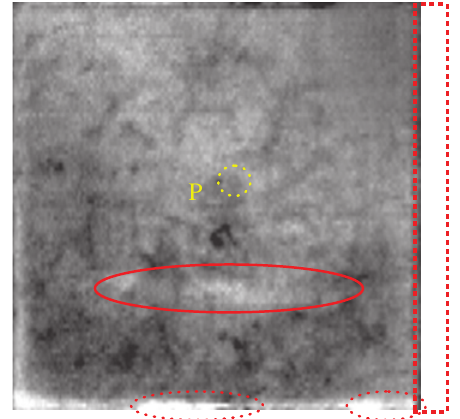
Figure 14 SOBI-RO result applying IR (SPT)